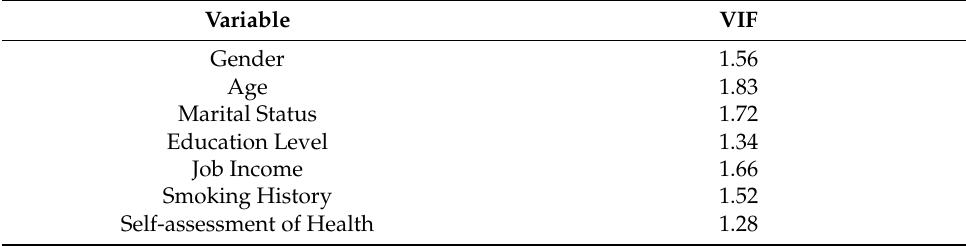
Table 2. Multicollinearity